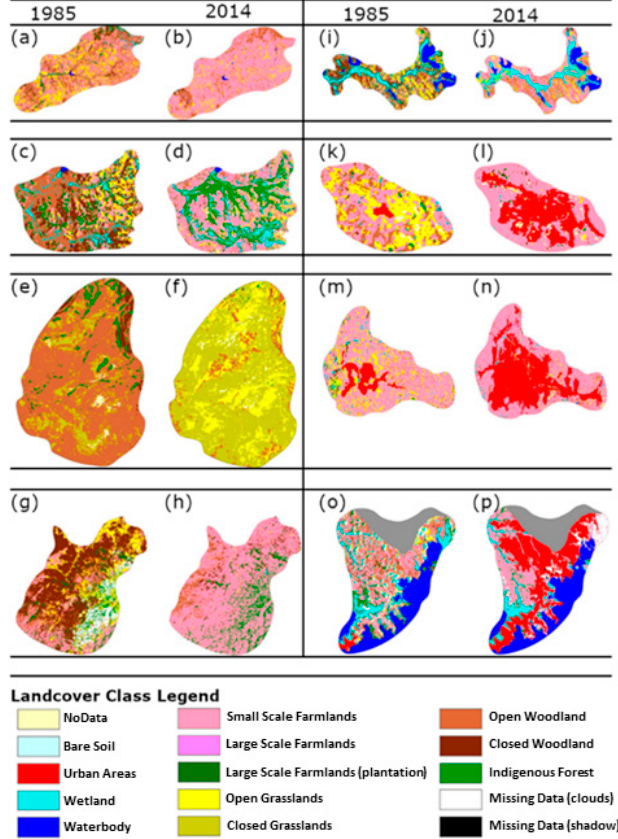
Figure 5. Selected regions of the LVB showing remarkable changes in land cover between 1985 and 2014. Letters ( a – p ) indicate the locations in the study area map on Figure 1.